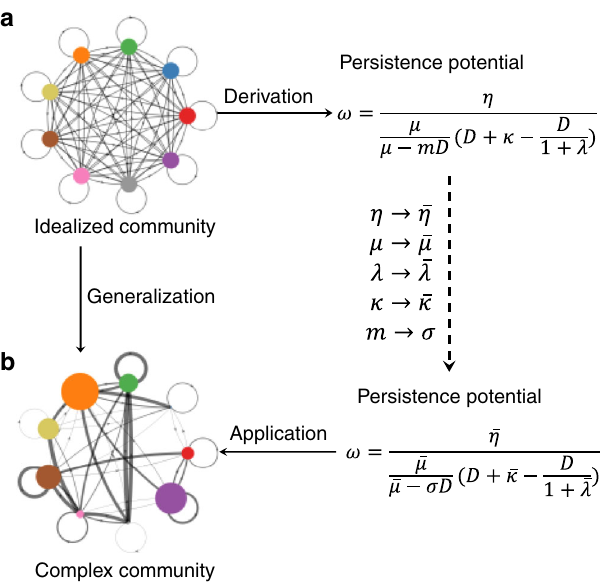
Fig. 2 Developing the persistence potential ( ω ) of plasmids. a Derivation of ω for an idealized microbial community. Here, the community is fully symmetric in terms of parameters and population sizes. Each colored circle represents a constituent species; the area of the circle is proportional to the species size. Each directed arrow represents the transfer of a plasmid, with the arrow thickness indicating the transfer rate. In this case, ω can be analytically derived. b Generalization of ω . We generalized the formulation of ω by replacing each parameter with its weighted average, which factors in the heterogeneity of species size. The weighted averages of μ , κ , and λ the total number of species and s i represents the abundance of i -th species. P m s s ¼ s i . Both donor and i ¼ 1 T is the total abundance of all the species: T recipient cell densities contribute to the conjugation ef fi ciency; thus, the represents the abundance of the donor species, s j the recipient species, and η ij the transfer rate from the donor to the recipient. In the formulation of the generalized persistence potential, the species number m was replaced with P the Shannon effective number of species, σ , which is calculated through m si si σ ¼ e (cid:2) s T ln s T i ¼ 1